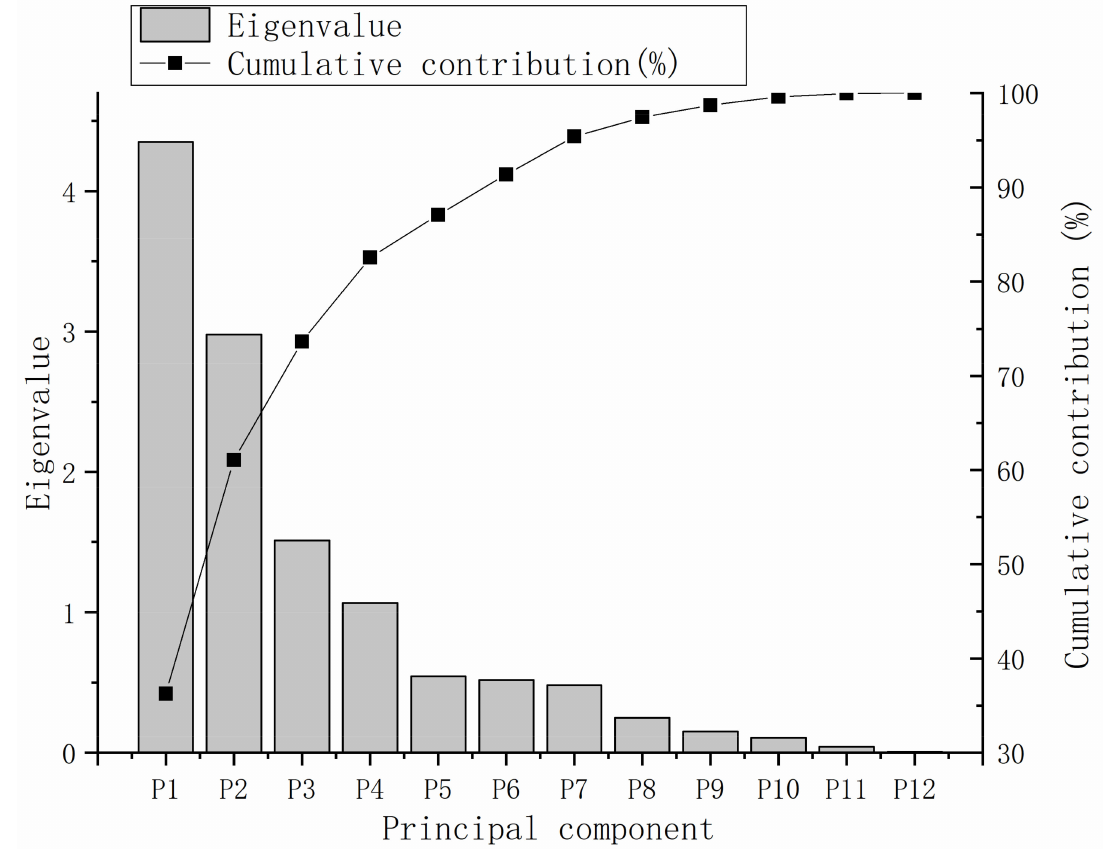
Figure 3. Results of the principal component analysis showing eigenvalue and cumulative